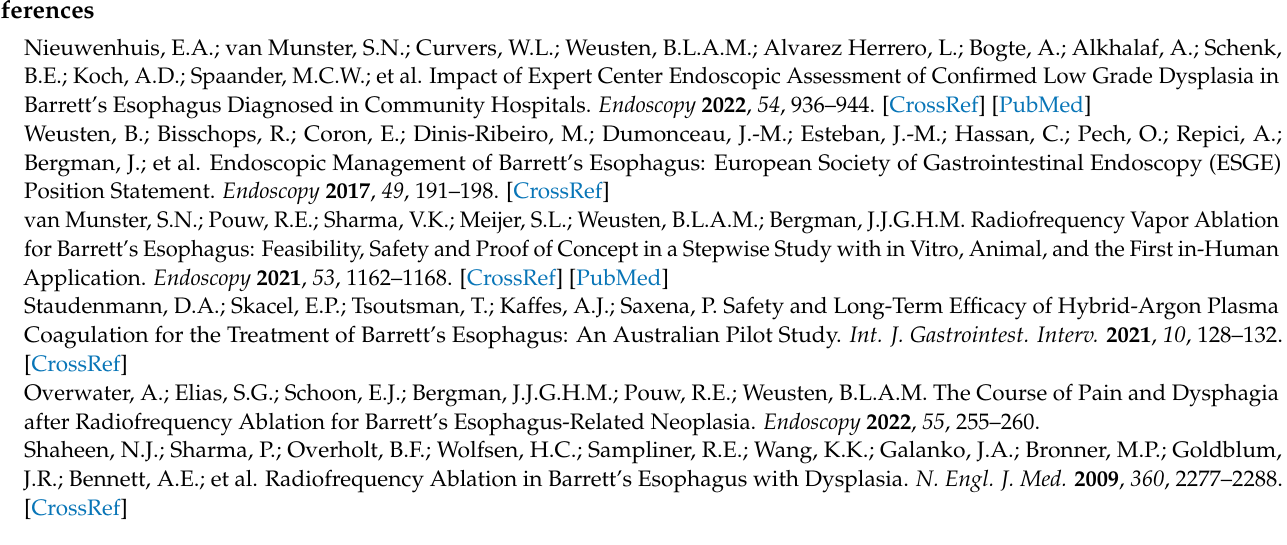
Supplementary Figure S1: Funnel plots for the proportions of outcomes’ achievement after hybrid argon plasma coagulation (hAPC) for Barrett esophagus (BE) ablation. Supplementary Figure S2: Funnel plots for the proportions of outcomes’ achievement after hybrid argon plasma coagulation (hAPC)-assisted endoscopic mucosal resection (EMR) of colonic lesions with more than 20 mm. Supplementary Figure S3: Results of the reporting quality analysis, using the Critical Appraisal Skills Programme (CASP)